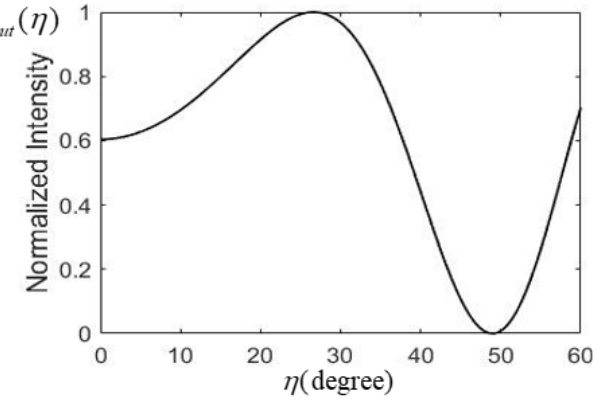
Figure 4. The normalized output intensity for d = 25 mm at λ = 0.5 µm.